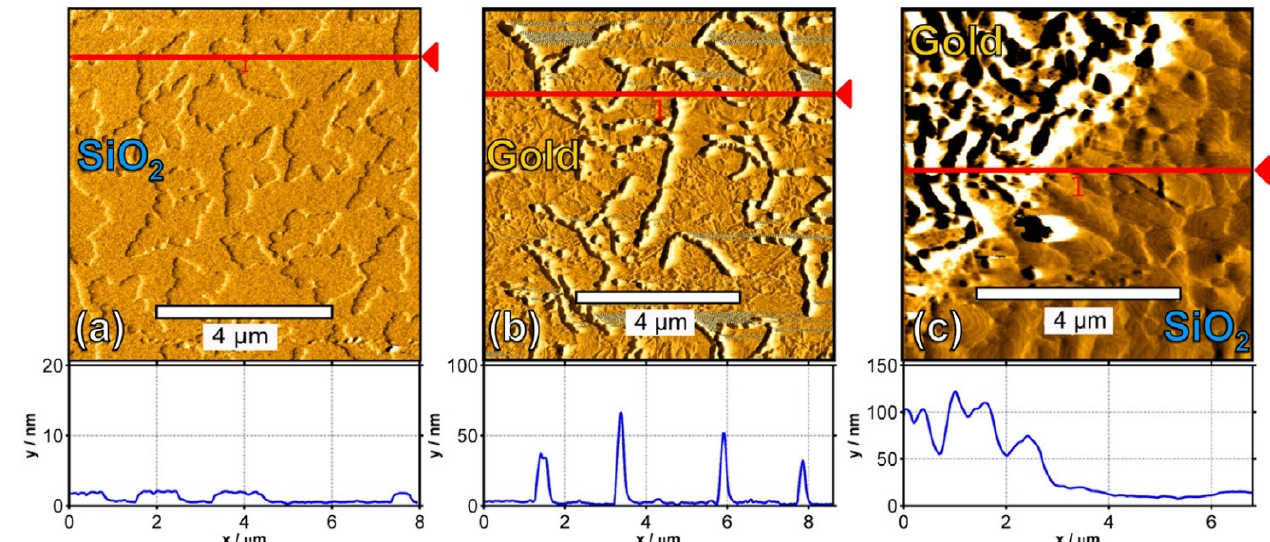
Figure 13. Pentacene deposition at 300 K: 1.5 monolayers on SiO 2 ( a ) and gold ( b ), plus 7.5 monolayers on the gold contact– channel transition region ( c ). The corresponding cross-sections are indicated in the AFM scans by a line and shown underneath correspondingly. Reprinted with permission from ref. [92]. 2015 Elsevier.